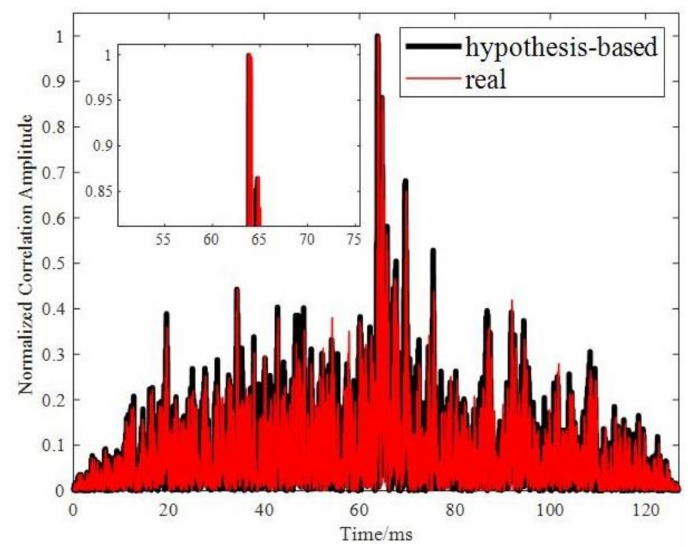
Figure 3. Comparison of correlation results.